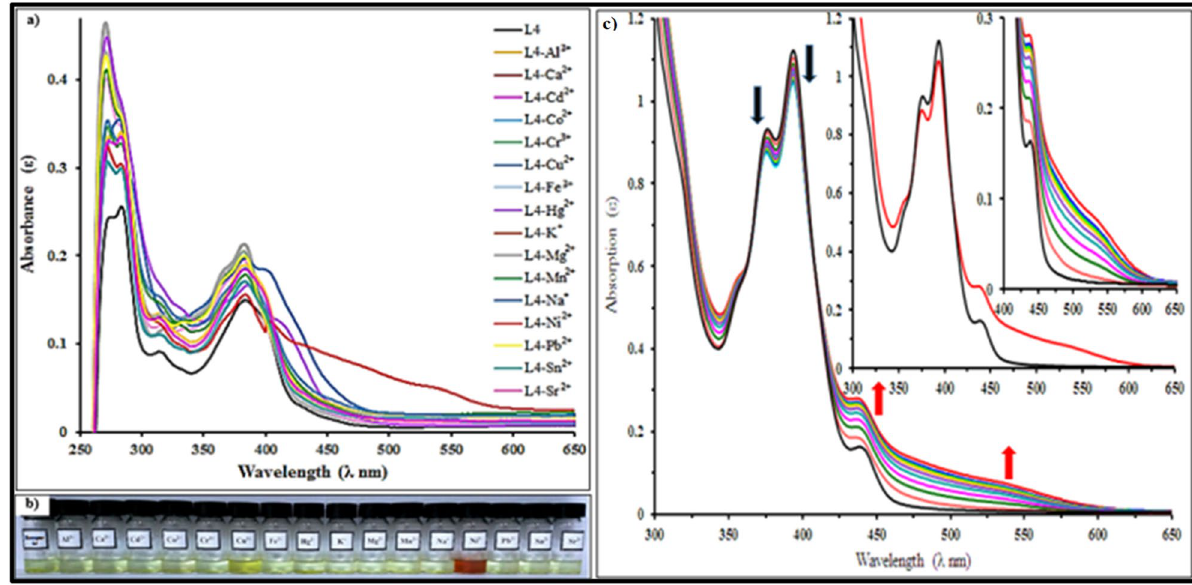
Figure 2. ( a ) Absorption spectral changes of L4 (20 µM) in the presence of different metal ions in DMSO– H 2 O (v/v 1:2, HEPES buffer pH = 7.4), ( b ) Visual colorimetric response of receptor L4 upon addition of one equivalent various metal ions, ( c ) Absorbance titration spectra of receptor L4 (20 µM) in the presence of various